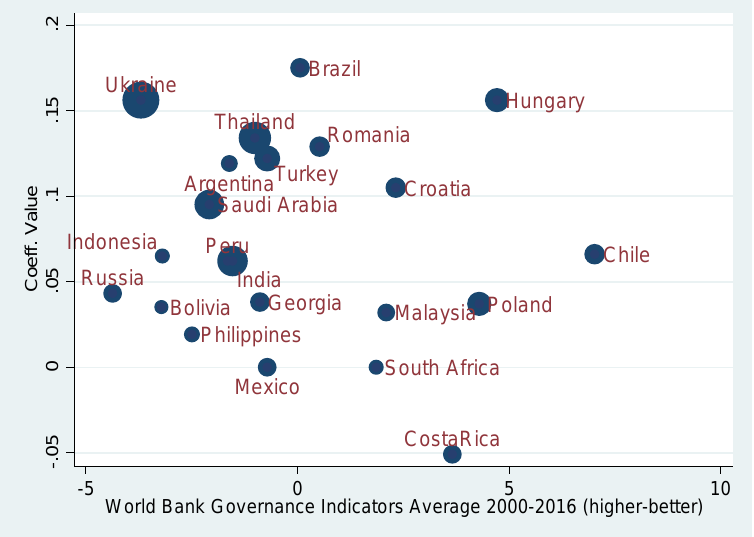
Figure 4 : Weak correlation between institutional quality and benefits from imports from China